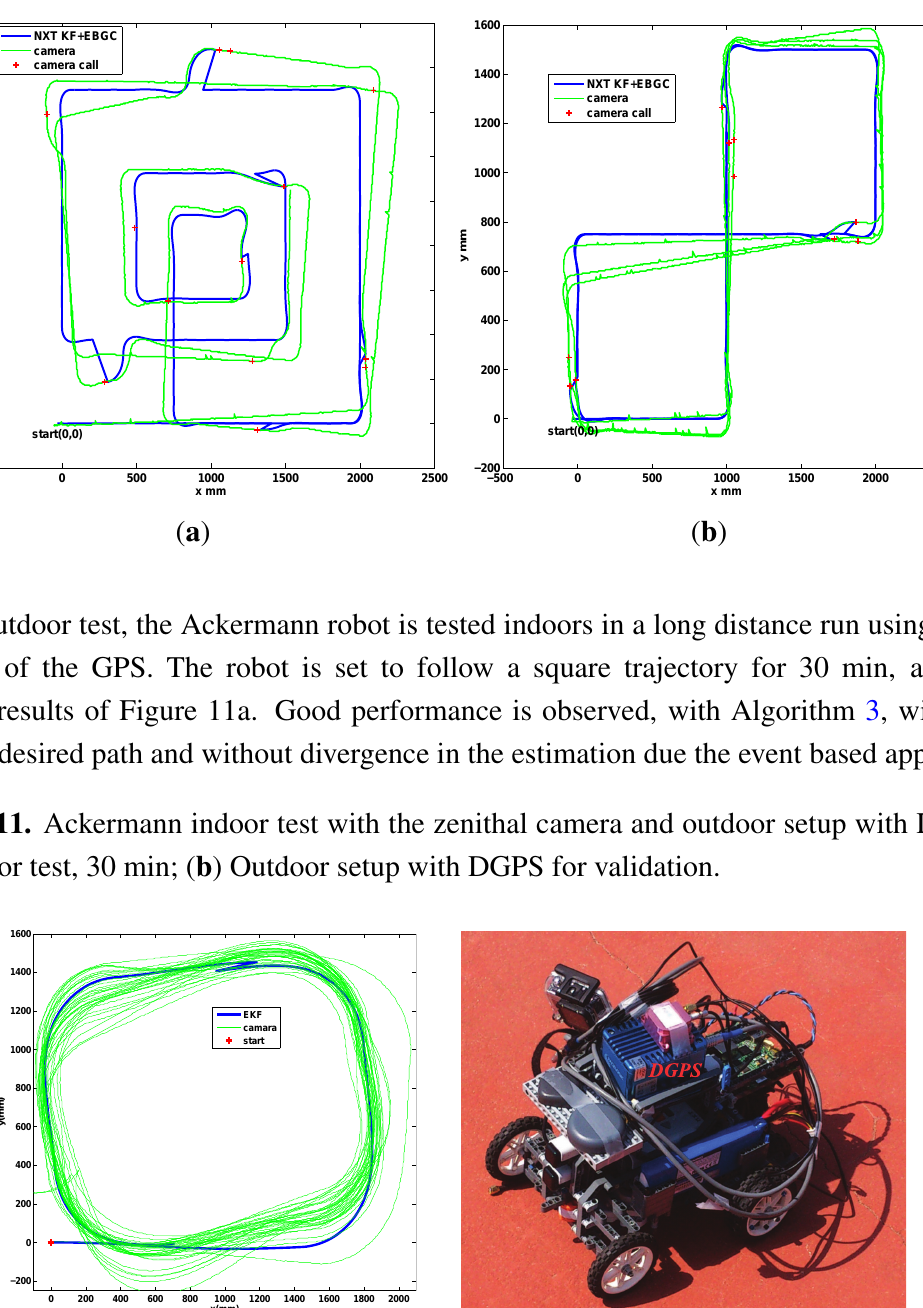
Figure 10. Five minutes run, global update performance, differential robot. ( a ) Square Spiral; ( b ) Double square.